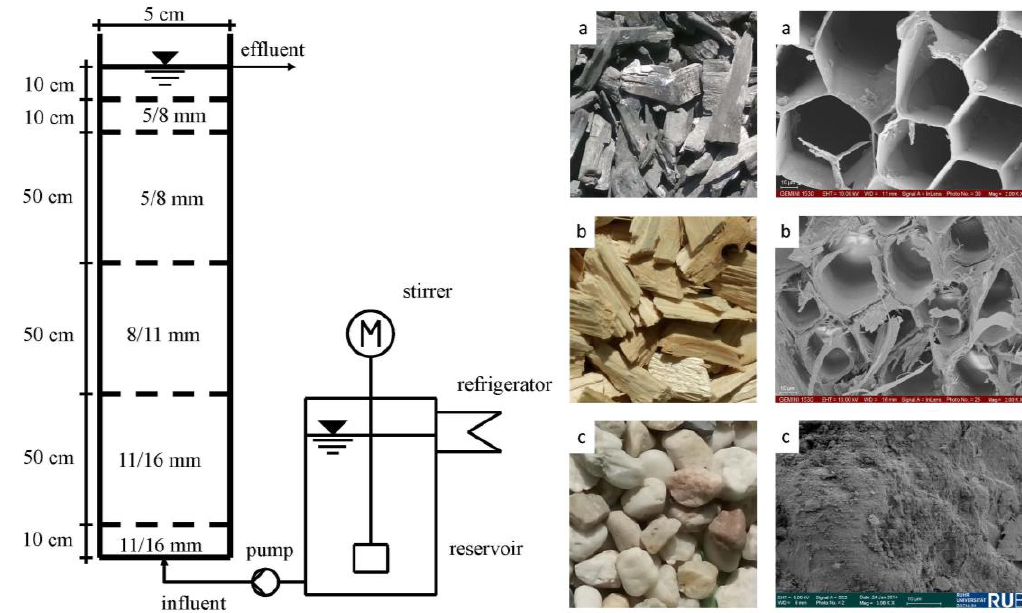
Figure 1. Schematic drawing of experimental setup. Pictures and scanning electron microscope (SEM) images from used ( a ) biochar, ( b ) woodchips, and ( c ) gravel.